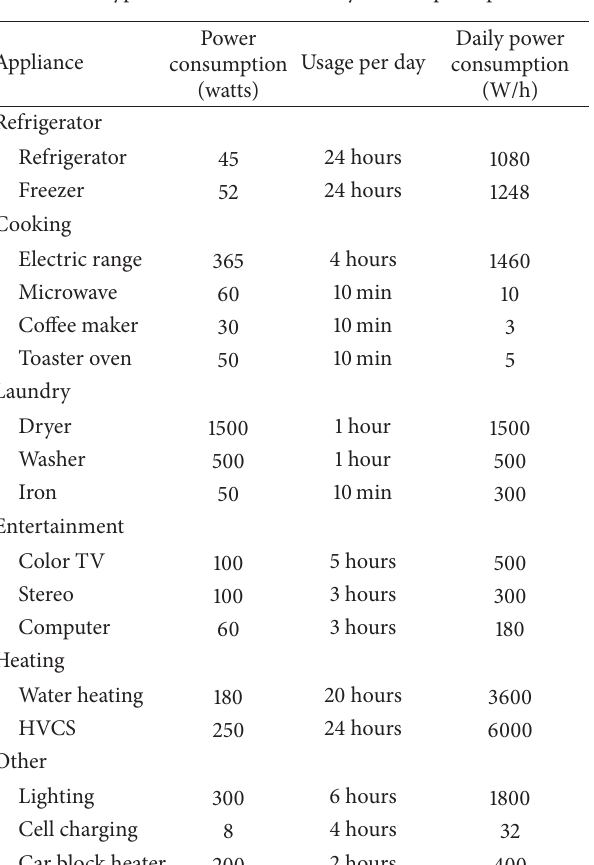
Table 1: Typical household electricity consumption